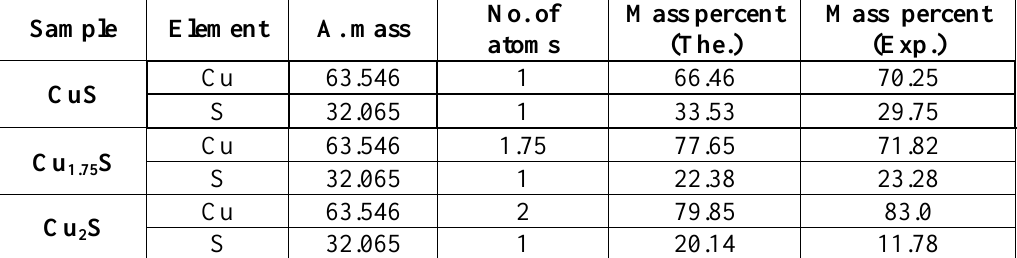
Table 1: The elemental analysis for Cu method at different ratios of Cu.